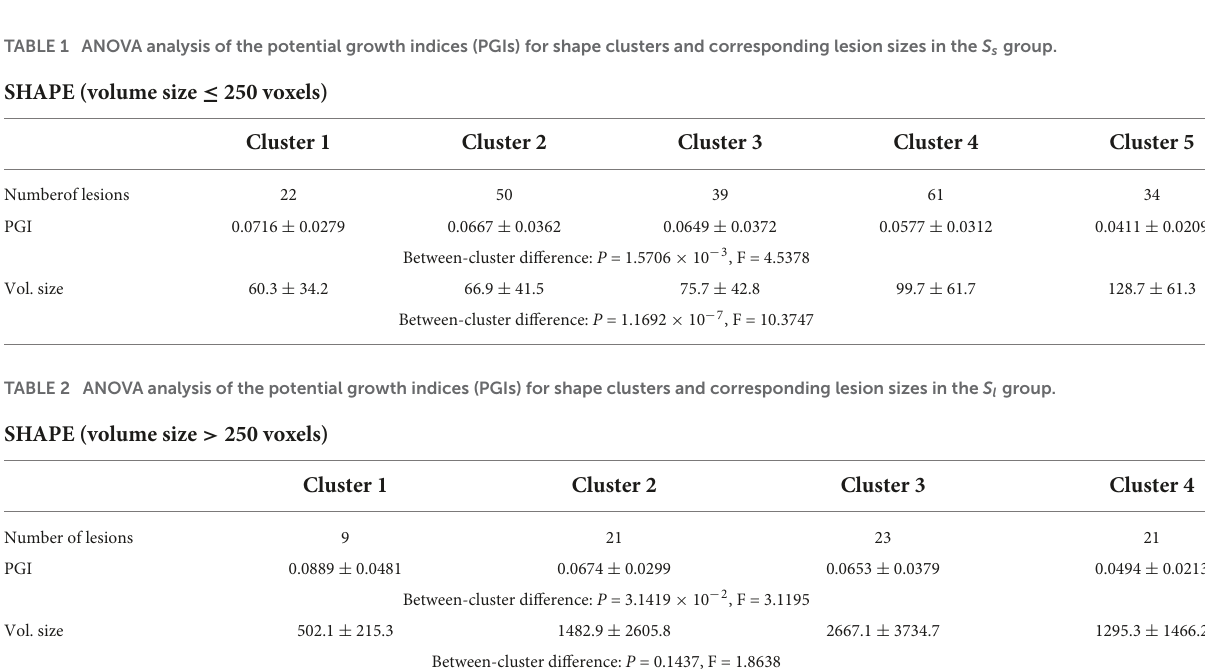
TABLE 1 ANOVA analysis of the potential growth indices (PGIs) for shape clusters and corresponding lesion sizes in the S s group.